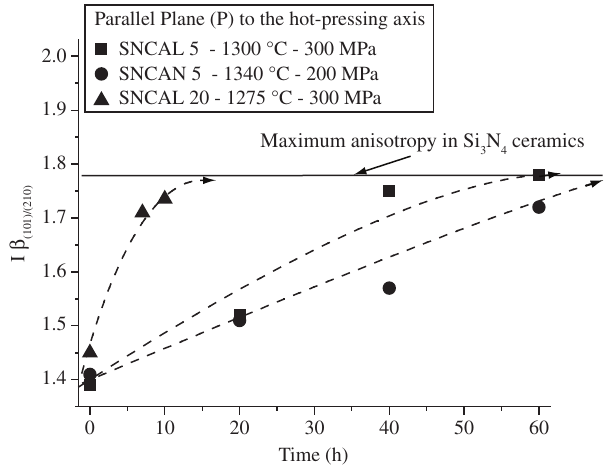
N grains of the compositions SNCAL 5, 3 4